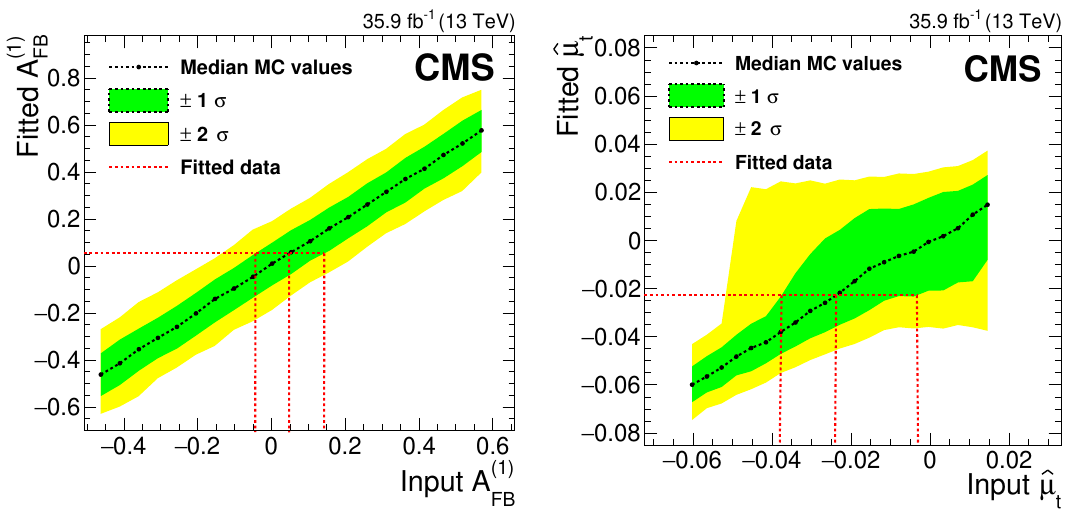
Figure 7 . Neyman constructions for the A (1) (left) and ^ (cid:22) (right) parameters of interest in groups t FB of 1000 pseudo-experiments generated with systematic uncertainty nuisance parameters allowed to vary. The horizontal dotted lines indicate the values of the parameters determined from the (cid:12)ts and the vertical dotted lines indicate where these values intersect with the central value and uncertainty contours from the pseudo-experiment groups.